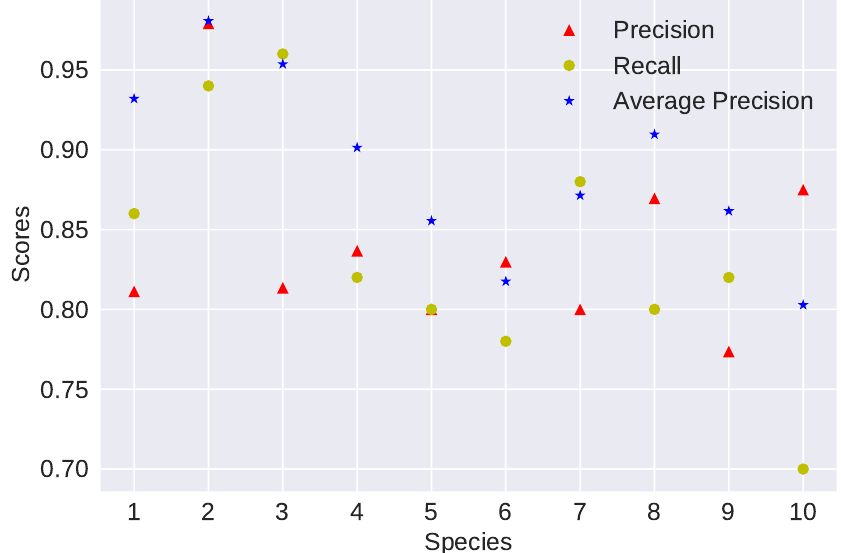
Figure 7. The precision, recall, and average precision for individual species classified in a subset composed of 10 randomly selected species are compared. The largest and the smallest value of each performance measure indicate a relatively large variation and strong dependence on the particular species under